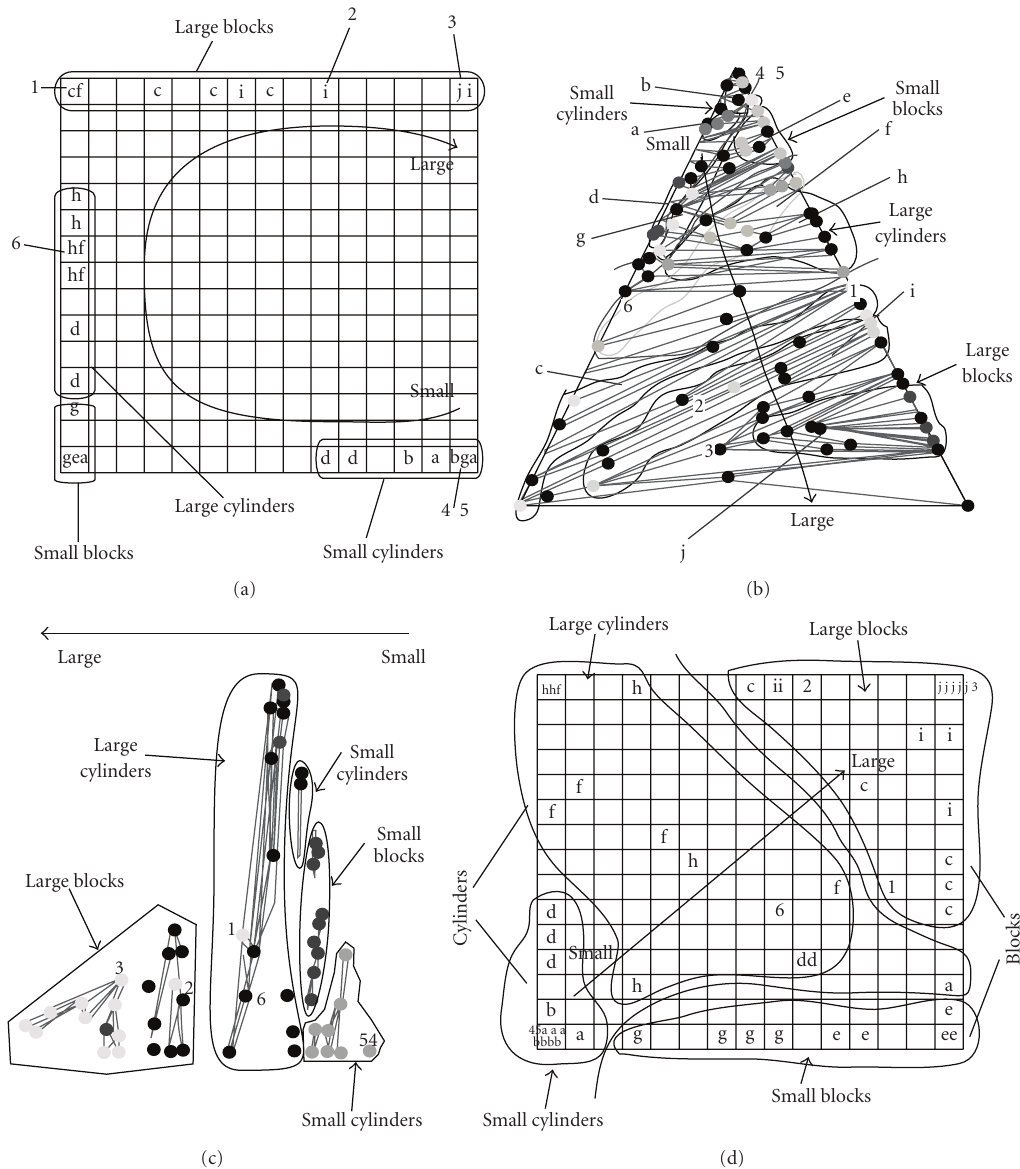
Figure 4: The test results of the four systems. (a) The SOM-based system is organized according to shape and size. Groups of large blocks, small blocks, large cylinders, and small cylinders can be distinguished. The activations tend to be located according to size of the objects in a clockwise manner. Individual objects can be discriminated to a large extent. (b) The GCS-based system produces similar results as the SOM- based system, that is, it is organized according to shape and size. The GCS-based system separates large blocks, small blocks, large cylinders, and small cylinders, and the objects are represented according to size with the smallest objects uppermost and the largest lowermost in the GCS. Also individual objects can be discriminated to a large extent. (c) The GCS-DN based system self-organized into subnetworks, where one or more subnetworks represent the categories large blocks, small blocks, large cylinders, and small cylinders. (d) The GG-based system separates large blocks, small blocks, large cylinders, and small cylinders, and the grid is organized according to size. Individual objects can be discriminated to a large extent. The 6 test objects (indicated with the numbers 1–6) not included in the training set activated neurons at proper locations perfectly in all systems but the GCS-DN based system. In that system, object 1 triggered activation in the wrong subnetwork. (see Table 1 for the meaning of the